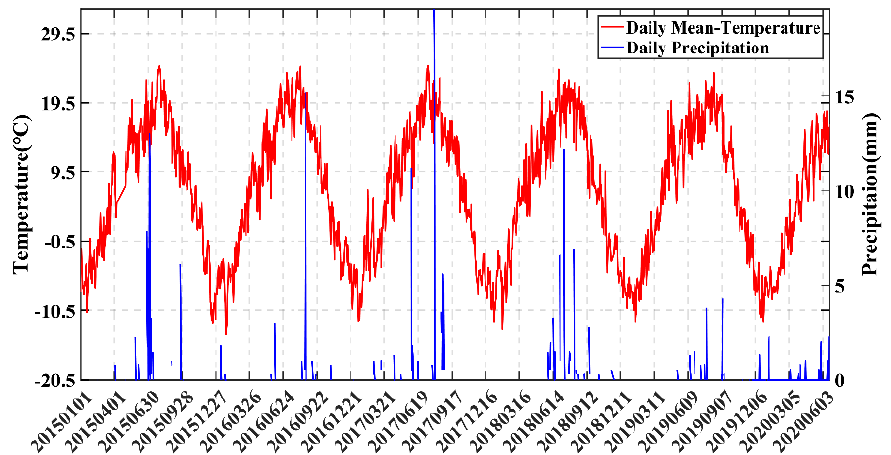
Figure 3. The geographical environment and transportation system in the study area, the black dotted lines indicate the faults, the sand flat and the saline mud flat in the blue dotted rectangle is the study area.